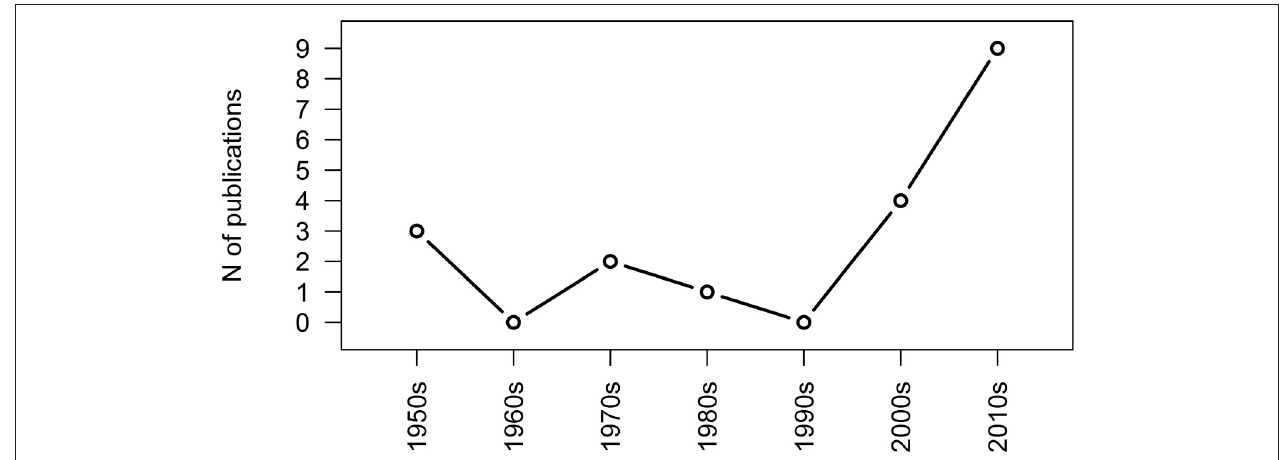
FIGURE 1 | Timeline of publications on IP in psychotherapy by